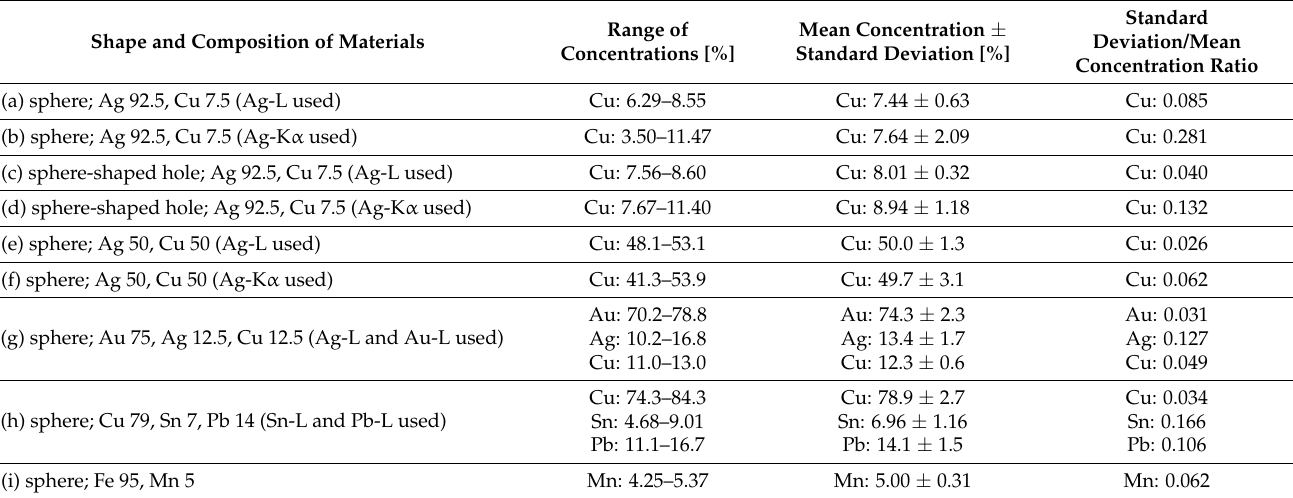
Table 1. Summary of Monte Carlo simulations of XRF micro-analyses of various materials with irregular